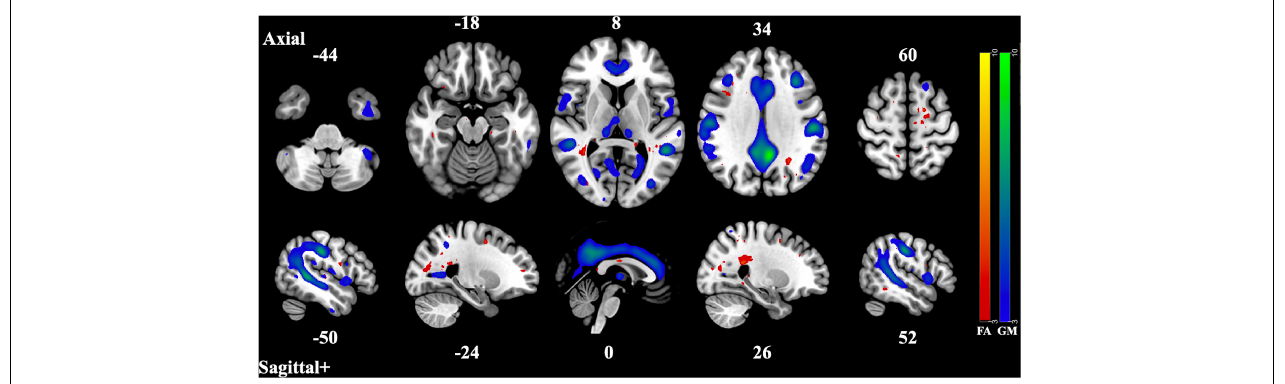
FIGURE 2 | Component Pair 2, Intermodal spatial map highlighting the correlated FA and GM changes that differ significantly (Bonferroni-corrected for multiple comparisons), HC > SZ, z > |3|. pICA correlation between structural networks, r = 0.59 ( t = 9.05, p = 6.18 × 10 – 16 ). FA cases vs. controls differences, t = 2.99, p = 0.0032, GM cases vs. controls, t = 2.67, p = 0.0082. Red-yellow represents the FA group differences, blue-green represents the GM group differences. See Supplementary Figures 3 , 4 for full axial and sagittal images.